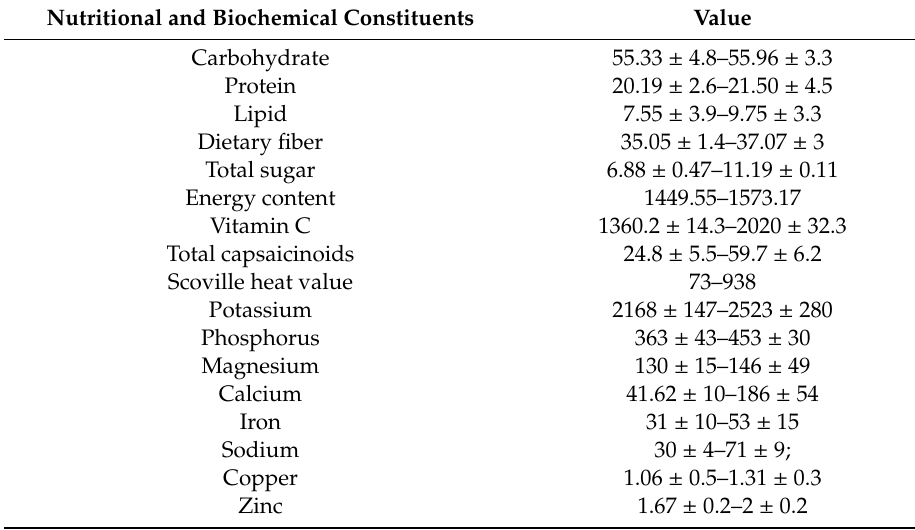
Table 1. Nutritional and biochemical constituents of C. annuum fine particles at diverse harvest periods. Nutritional and Biochemical